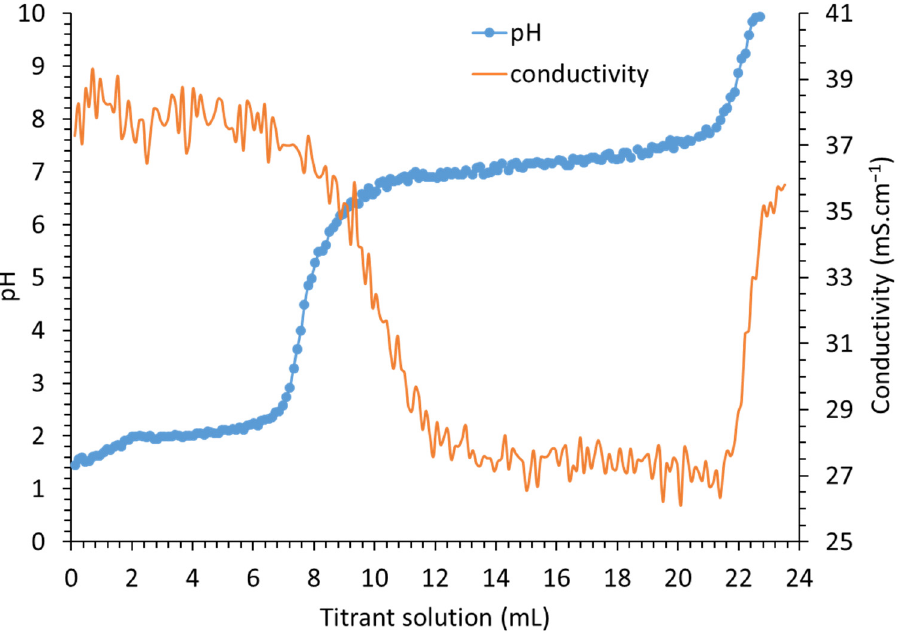
Figure 1. Titration curve of 100 mL of a solution containing the cations mixture Co 2+ (0.15 M) and Fe 3+ (0.05 M) using the alkaline titrant solution of NaOH (2.80 M) and Na 2 CO 3 (0.78 M).